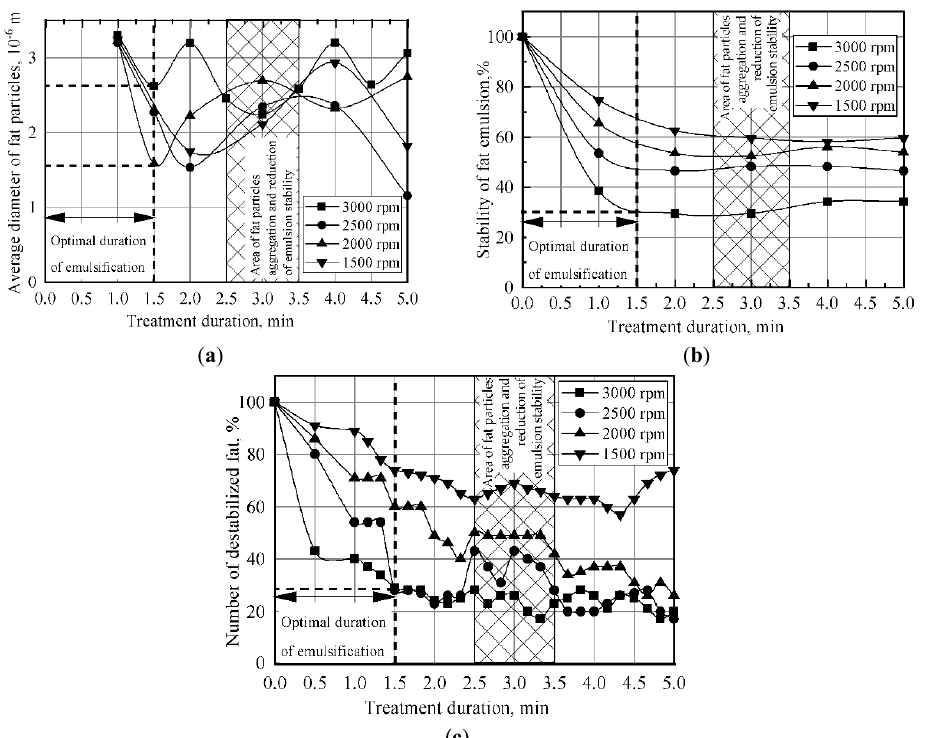
Figure 7. Variance in the degree of dispersion and the stability of fat emulsion in the process of treatment in the emulsification device: ( a ) average diameter of fat particles; ( b ) stability of fat emulsion; ( c ) number of destabilized fat.